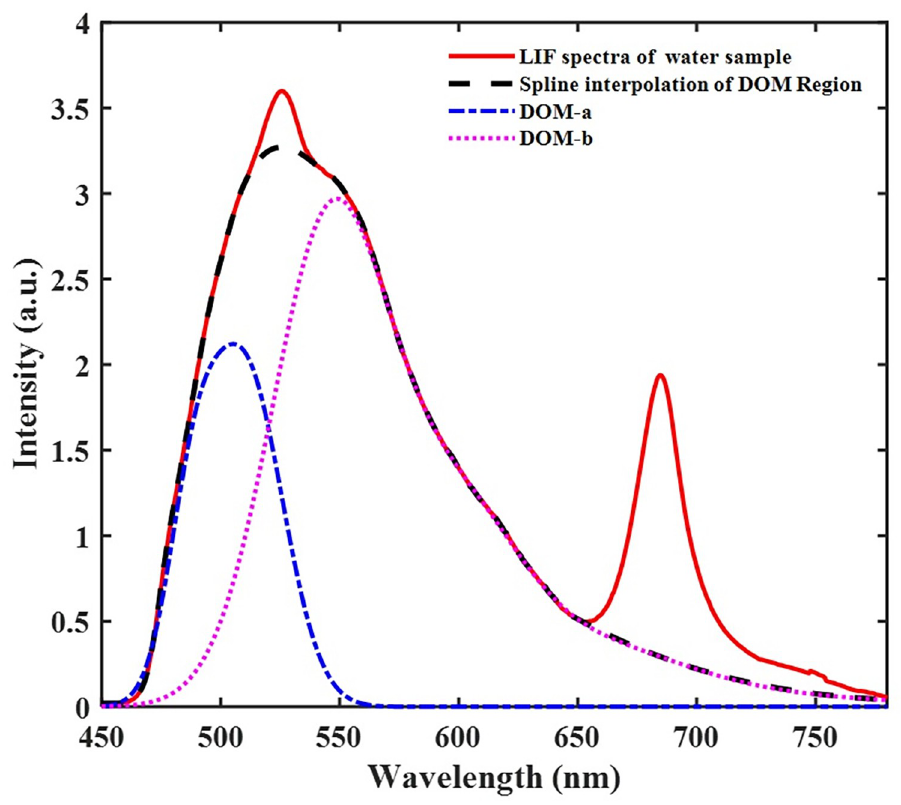
Fig 7. Deconvolved LIF spectra showing the constituents of water samples from mosquito breeding